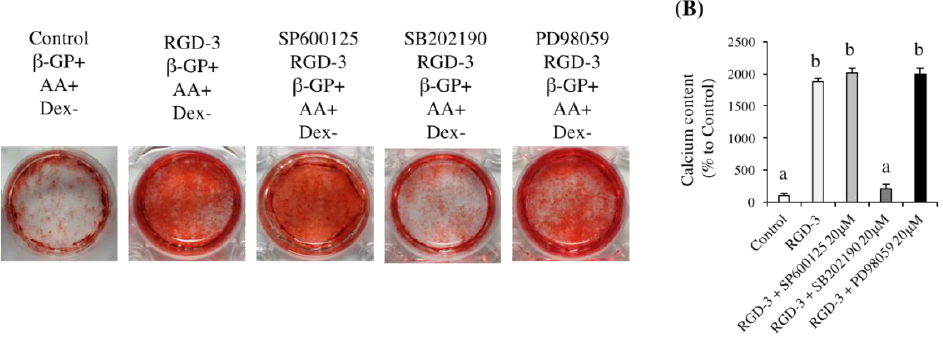
Figure 8. ARS staining in response to MAPK pathway inhibitors. hDPSCs were spread on non-TCPP plates coated with 1 M RGD-3 or dH 2 O (control) and were then exposed to 20 μM of one of three MAPK pathway inhibitors (SP600125 for JNK, SB202190 for p38 and PD98059 for ERK) on day 6 in serum-free DMEM for 2 h. Then, the medium was changed, and culture was continued. ( A ) Photo- graphs of mineral nodules formed after 30 days of culture. ( B ) CPC quantification of mineralized product staining intensity in ( A ). p38 inhibitor neutralizes the effect of RGD-3 on hDPSC minerali- zation. n = 3, different lowercase characters denote significant differences compared to the control ( p < 0.05 vs. control). 4. Discussion In the present study, the significance of RGD peptides in DPP sequence were ob- served in terms of differentiation and mineralization and the mechanism behind their ef- fects was explored as well. The effects of RGD peptides were investigated by dissolving the RGD peptide powders with dH 2 O and physically coating non-TCPS. The surfaces were left unwashed after the coating was dried, leaving all the peptides on the surfaces. Afterwards, hDPSCs were grown on the coated surfaces and their responses were ob- served. There was a noticeable difference in the number of cells attached on to the sur- faces, starting from day one. This supports the previous statements from multiple studies that the RGD contains cell attachment properties, which may have played an active role in attracting more cells to the surface and eventually spreading out the cells faster. Ac- cording to a study [19], initial cell attachment rate is an indication of matrix